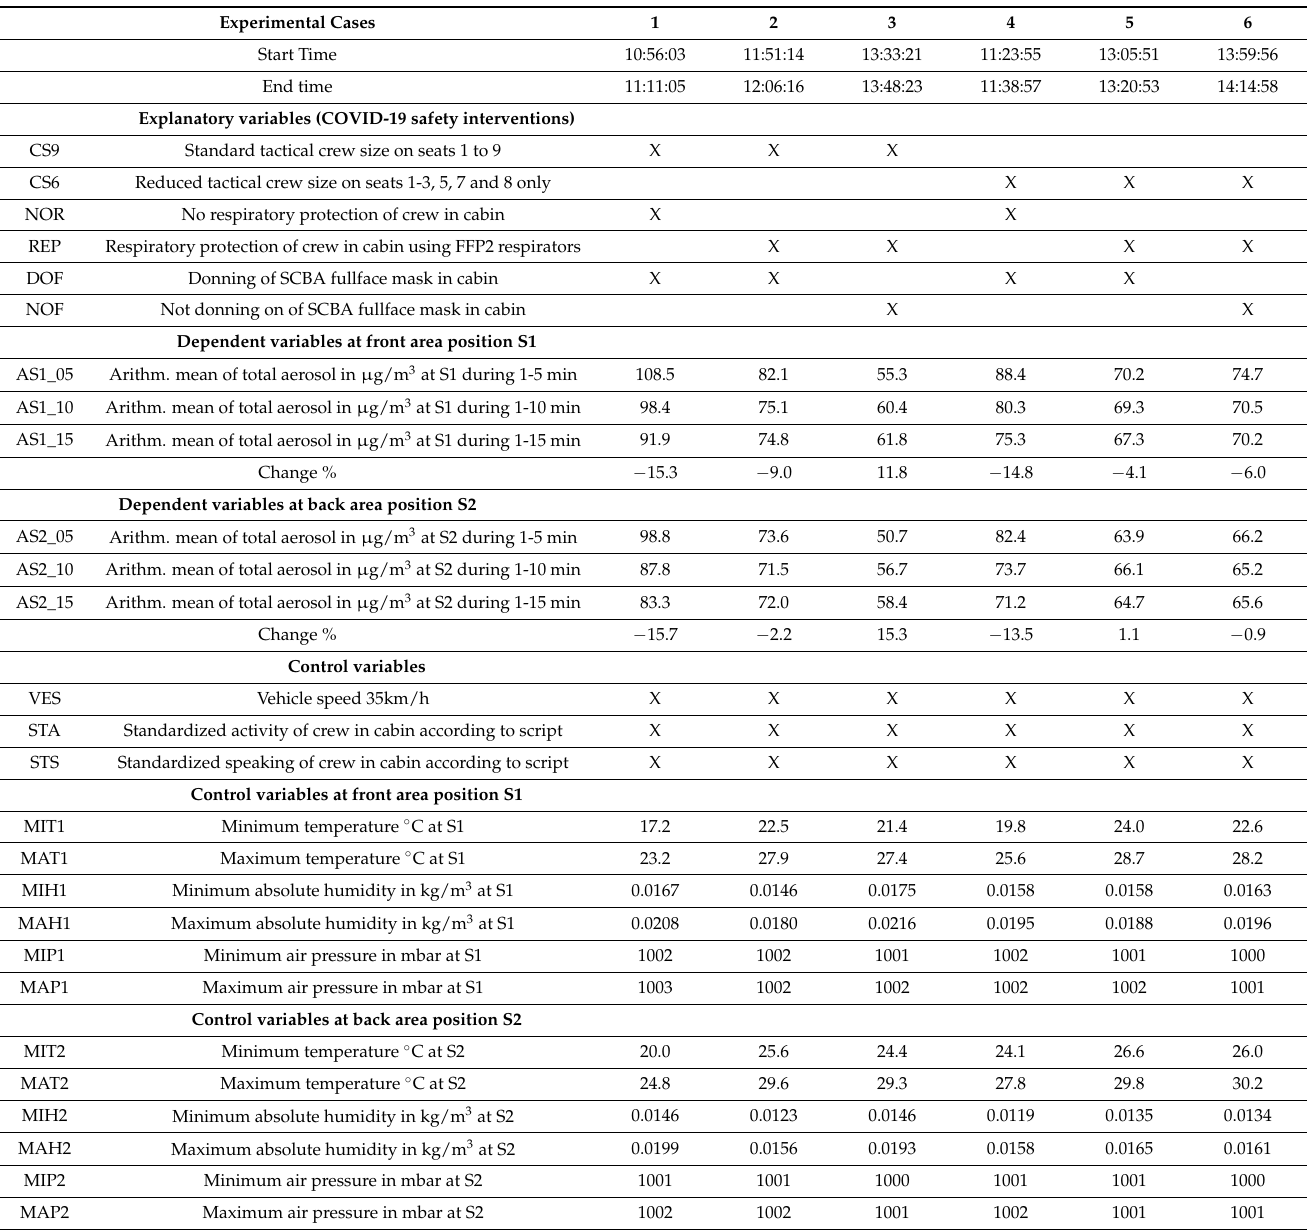
Table 2. Experimental settings and